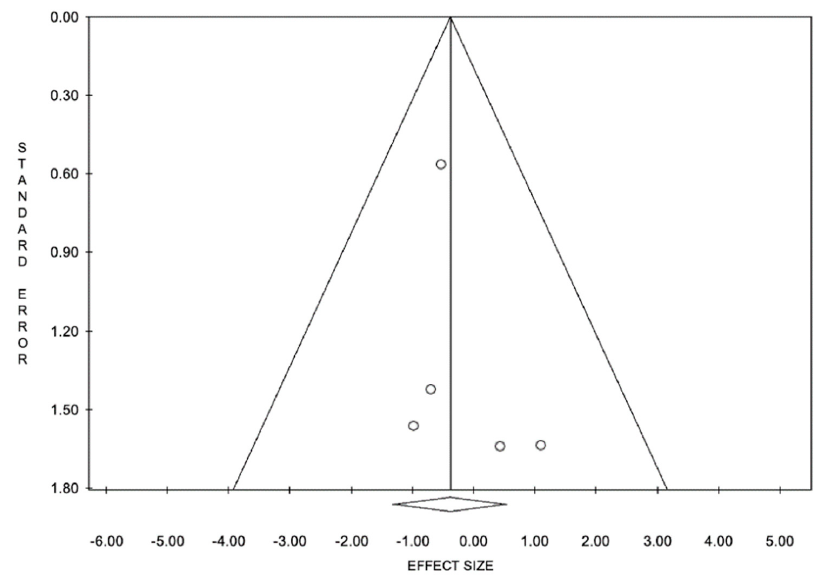
Figure 8. Funnel plot for meta-analysis of incidence of myocardial infarction. Funnel depicts no publication bias for meta-analysis of incidence of myocardial infarction in anti-PCSK9 group vs. control group .